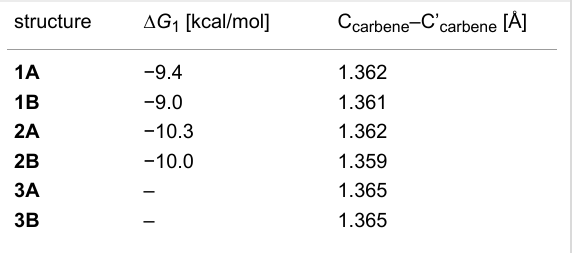
Table 1: Calculated dimerization energies ( ∆ G 1 ) in CH 2 Cl 2 for carbenes 1 and 2 and the C carbene –C’ carbene bond lengths of all corre- sponding